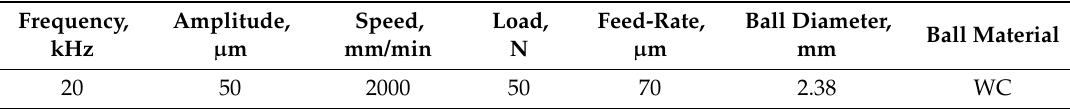
Table 3. UNSM process